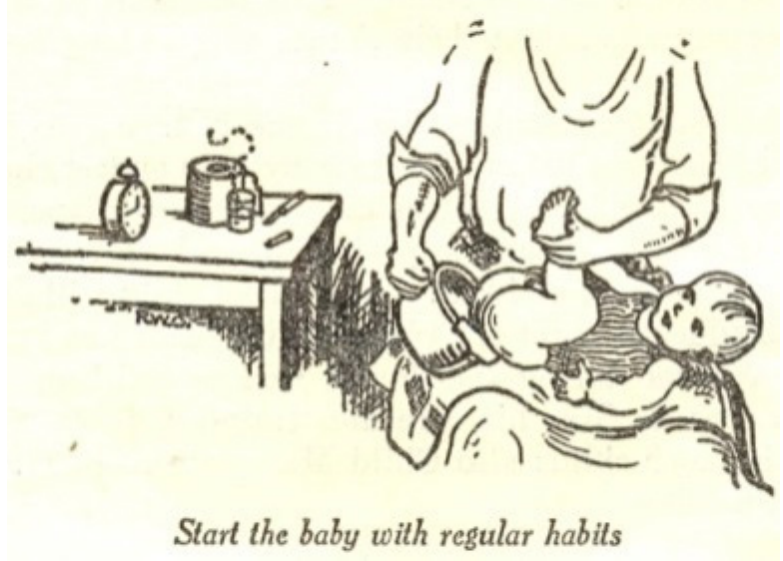
Figure 18. Early Bowel Training.